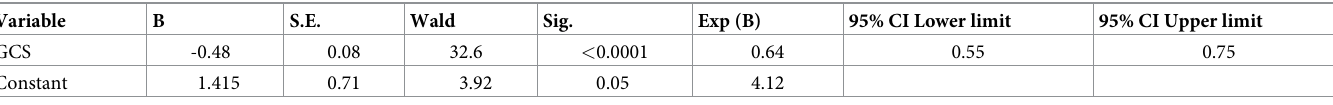
Table 3. Backward logistic regression model showing the predicting factor of mortality in patients having facial injuries. Variable B S.E. Wald Sig. Exp (B) GCS 0.75